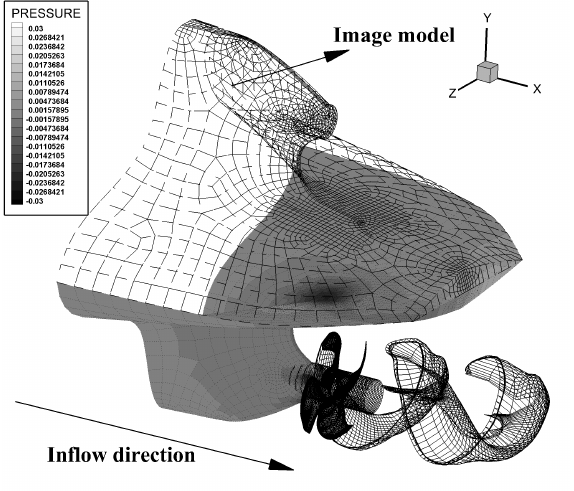
Figure 26. Open water characteristics of P2772 propeller predicted by BEM and the model scale experiment; P / D = 0.87 ( r / R = 0.7).